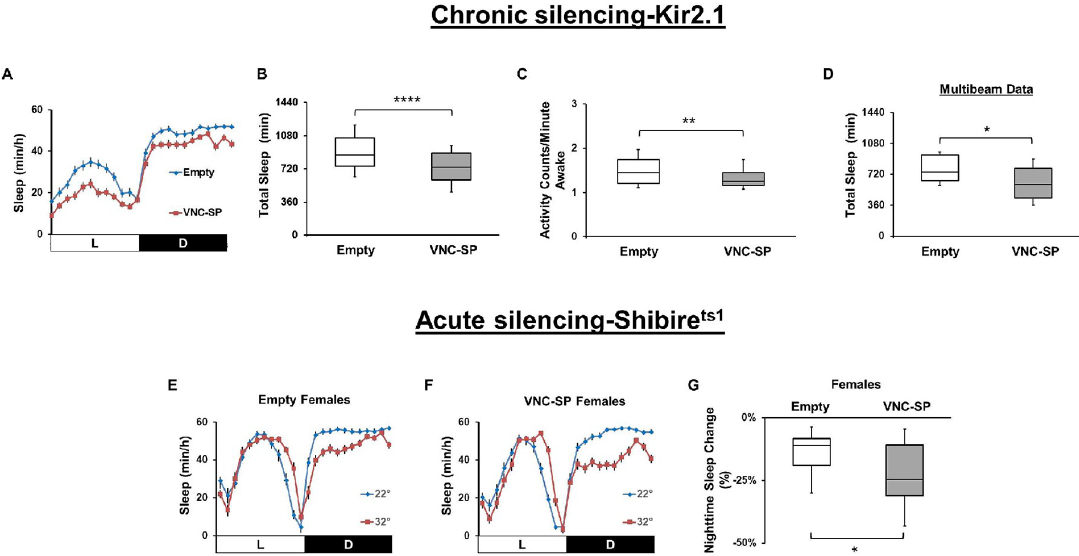
Fig 3. Silencing VNC-SP neurons reduces sleep. ( A ) Sleep profile in minutes of sleep per hour for control ( Empty-AD ; 23E10-DBD > UAS-Kir2 . 1 , blue line) and VNC-SP > Kir2 . 1 ( VT013602-AD ; 23E10-DBD > UAS-Kir2 . 1 , red line) female flies. ( B ) Box plots of total sleep time (in minutes) for flies presented in (A). A two-tailed unpaired t test revealed that total sleep is significantly reduced in VNC-SP > Kir2 . 1 female flies compared to controls. ���� P < 0.0001, n = 58–60 flies per genotype. ( C ) Box plots of locomotor activity counts per minute awake for flies presented in (A). Two-tailed Mann–Whitney U tests revealed that activity per minute awake is significantly reduced in VNC-SP > Kir2 . 1 female flies compared to controls. �� P < 0.001, n = 58–60 flies per genotype. ( D ) Box plots of total sleep time (in minutes) for control ( Empty-AD; 23E10-DBD > UAS-Kir2 . 1 ) and VNC-SP > UAS-Kir2 . 1 female flies measured with the multibeam MB5 system. A two-tailed unpaired t test revealed that total sleep is significantly reduced in VNC-SP > Kir2 . 1 female flies compared to controls, � P < 0.05, n = 28–31 flies per genotype. ( E ) Sleep profile in minutes of sleep per hour for control ( Empty-AD; 23E10-DBD > UAS-Shi ts1 ) female flies at 22˚C (blue line) and 32˚C (red line). ( F ) Sleep profile in minutes of sleep per hour for VNC-SP > UAS-Shi ts1 female flies at 22˚C (blue line) and 32˚C (red line). ( G ) Box plots of nighttime sleep change in % for female flies presented in (E) and (F). Two-tailed unpaired t tests revealed that VNC-SP > Shi ts1 flies lose significantly more sleep when transferred to 32˚C compared with controls. � P < 0.05, n = 27–31 flies per genotype. The raw data underlying parts (B), (C), (D), and (G) can be found in S1 Data. VNC-SP, VNC